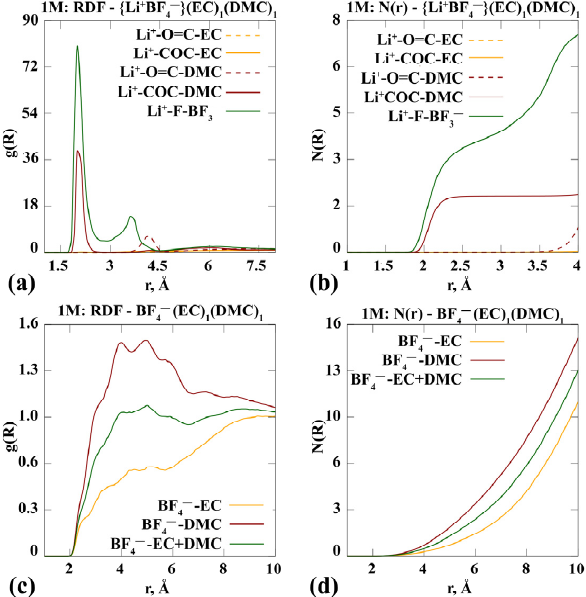
Figure 1. Radial distribution function g(R) ( a , c ) and statistical structural —factor N(R) ( b , d ) for a system modelling a 1 m {Li + BF 4 − } in (EC) 1 (DMC) 1 (1:1, vol.).